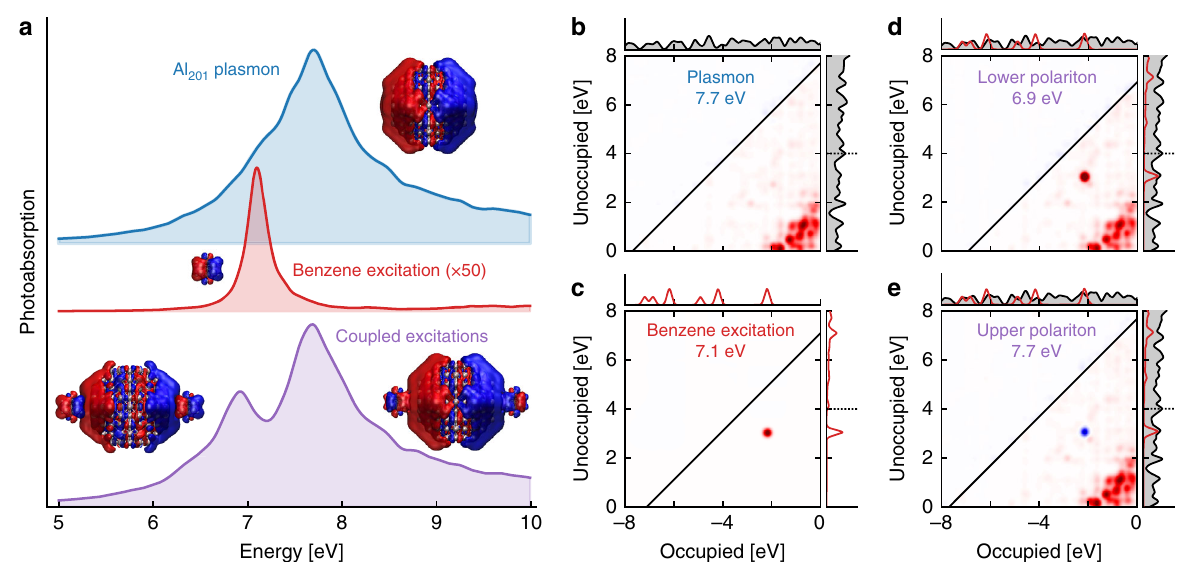
Fig. 1 Constituent elements of the strongly coupled system. a Strong interaction between a collective plasmon excitation of an Al 201 nanoparticle and a molecular resonance of benzene results in the formation of lower and upper polariton states. Insets show the induced charge densities at resonances. The spectra are to scale but offset for clarity. b – e Transition contribution maps (TCMs) of the ( b ) plasmon and ( c ) molecular resonance show, respectively, the collective and discrete nature of these resonances. TCMs for d the lower polariton (6.9 eV) and e the upper polariton (7.7 eV) show the mixture of plasmonic and molecular transition contributions. The molecular transition (from about − 2 to 3 eV) shows a clear symmetric and antisymmetric character with respect to the low-energy ( ≲ 2 eV) plasmonic transitions at the lower and upper polaritons, respectively, and the induced densities at the polariton energies visualize the corresponding in-phase and out-of-phase alignments (insets of panel a ). In the density of states the red line marks the contribution from benzene, multiplied by 5 for visibility, and the vacuum level at around 4 eV is marked by a dashed